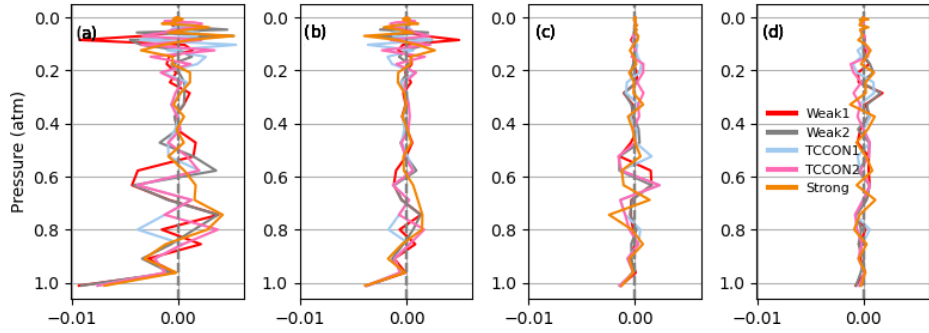
the residuals and those associated with the largest singular values represent the main patterns in the residuals, while the corresponding right singular vectors can provide information on the temporal frequency of these